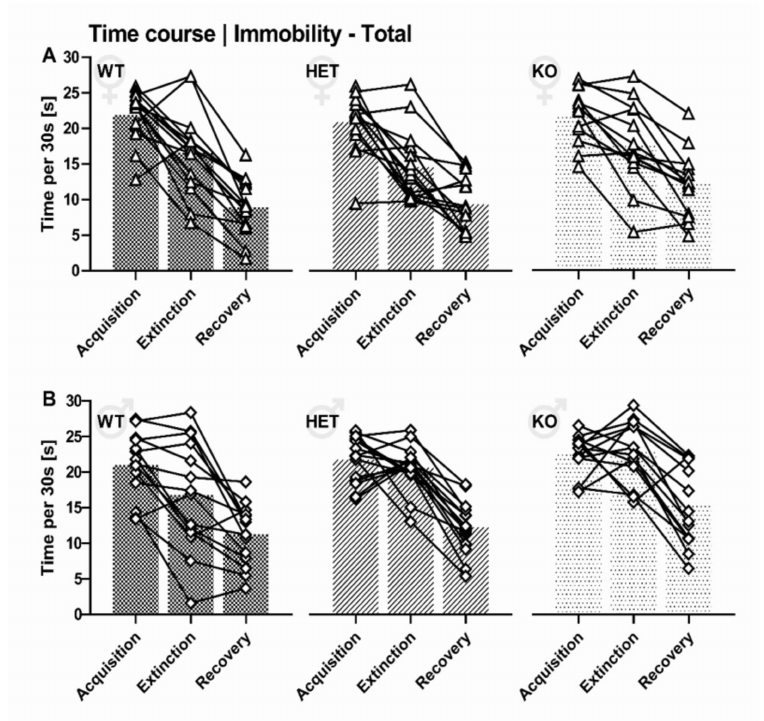
Figure 8. Inter-individual differences in immobility. Effects of SERT deficiency on immobility during acquisition, extinction, and recovery, depicted as individual values for female ( A , with triangles) and male ( B , white squares) rats. Additionally, means for SERT +/+ (checkered bars), SERT +/ − (striped bars), and SERT − / − (dotted bars) rats are shown. N = 44 female (15 +/+, 15 +/+, 14 − / − ), N = 43 male rats (14 +/+, 15 +/+, 14 − / − ) rats.